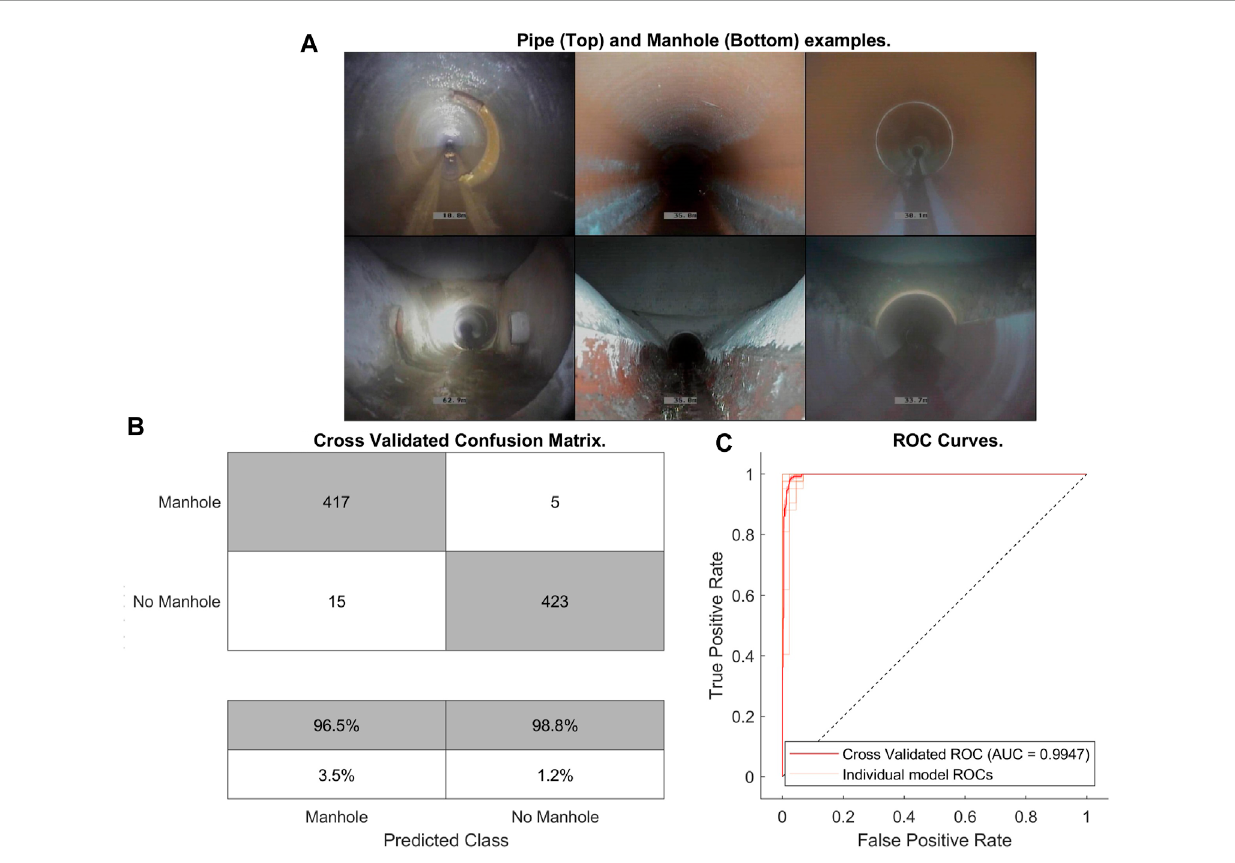
FIGURE 8 Manhole detection results. (A) Example images from pipes 1, 2 and 3 (left to right) respectively of the pipe image (top) versus the manhole image (bottom). (B) Classification confusion matrix from cross-validation data. (C) ROC curve for manhole detection.